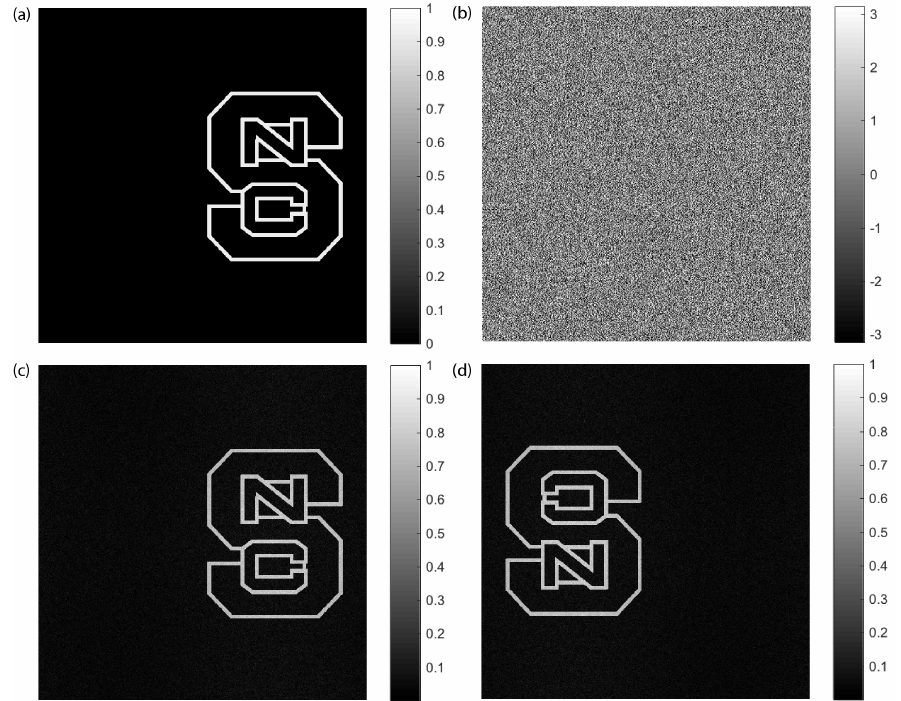
Figure 1. ( a ) Target image; ( b ) retrieved phase pattern; ( c ) simulated replay of the primary image, from one circular polarization; ( d ) simulated replay of the conjugate image, from the orthogonal circular